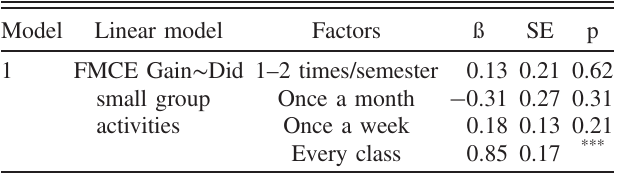
TABLE I. Linear regression of FMCE on frequency of small group